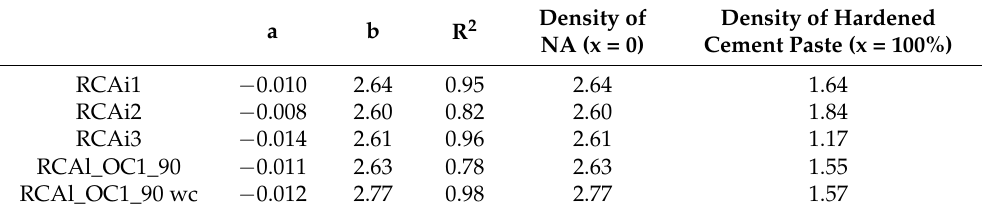
Table 8. Coefficients of the linear relationships between density and SFSA (y = ax + b).